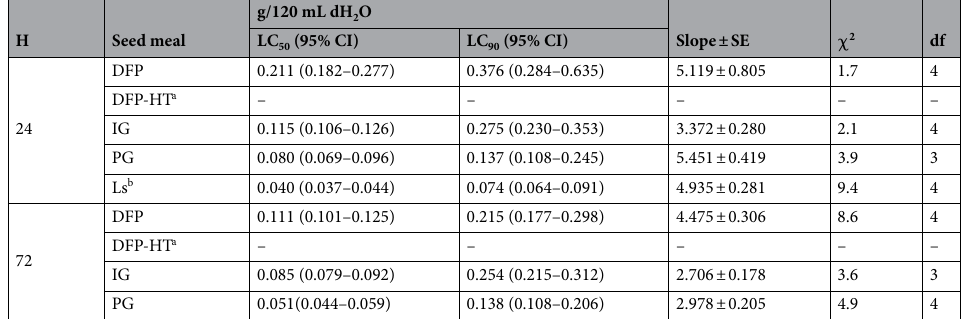
Table 2. Toxicity of Brassicaceae seed meals (DFP— Thlaspi arvense ; DFP-HT— Thlaspi arvense heat inactivated; IG— Sinapis alba (Ida Gold); PG— Brassica juncea (Pacific Gold; Ls—Lepidium sativum ) reported as LC 50 and LC 90 values for mortalities of late 3rd instar Aedes aegypti evaluated after 24 and 72 h of continuous treatment exposure. a Not effective as larval treatment. Data did not generate LC 50 and LC 90 values. b Ls— Lepidium sativum— all dead at higher concentrations after 24 h continuous